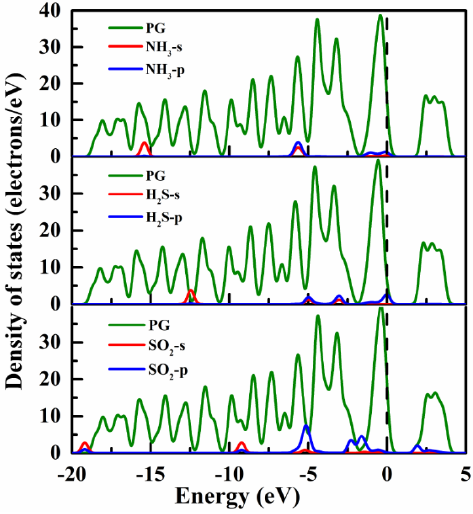
Figure 3. Density of states of NH 3 , H 2 S, and SO 2 adsorbed on the pristine PG. The dashed line is the Fermi level.